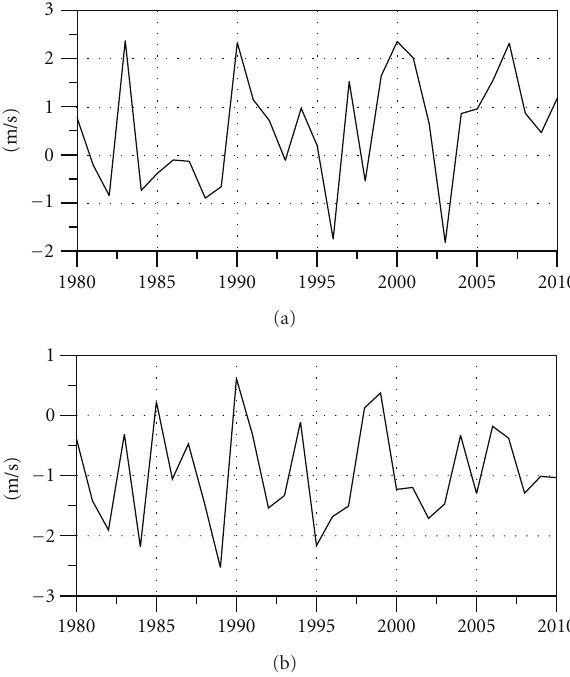
Figure 8: Meridional wind component in winter around Franz Joseph Land (a) and north of Svalbard